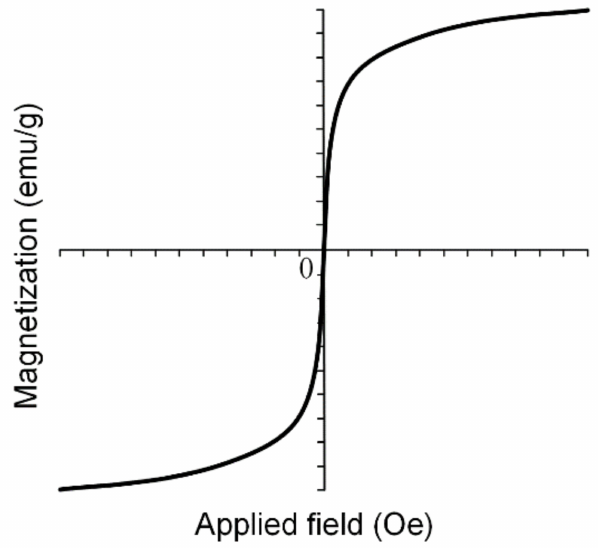
Figure 11. Magnetization curve for SPIONs can be modeled using sigmoidal functions. These types of particles do not present hysteresis phenomena, and so after external magnetic field removal, they do not tend to form aggregates.